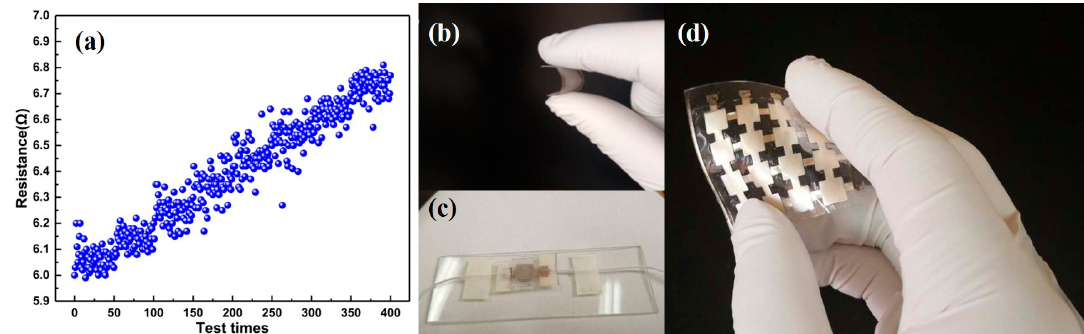
Figure 5. ( a ) 400 repeated tensile tests; ( b ) flexible characteristics of sensing unit; ( c ) physical figure of sensing unit; ( d ) physical drawing of sensor array.